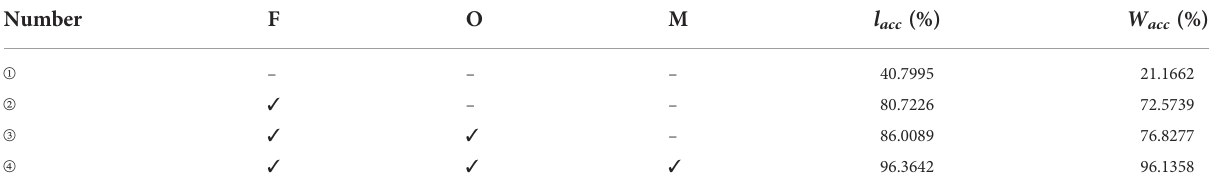
TABLE 10 Comparison of parameter measurements for different image processing